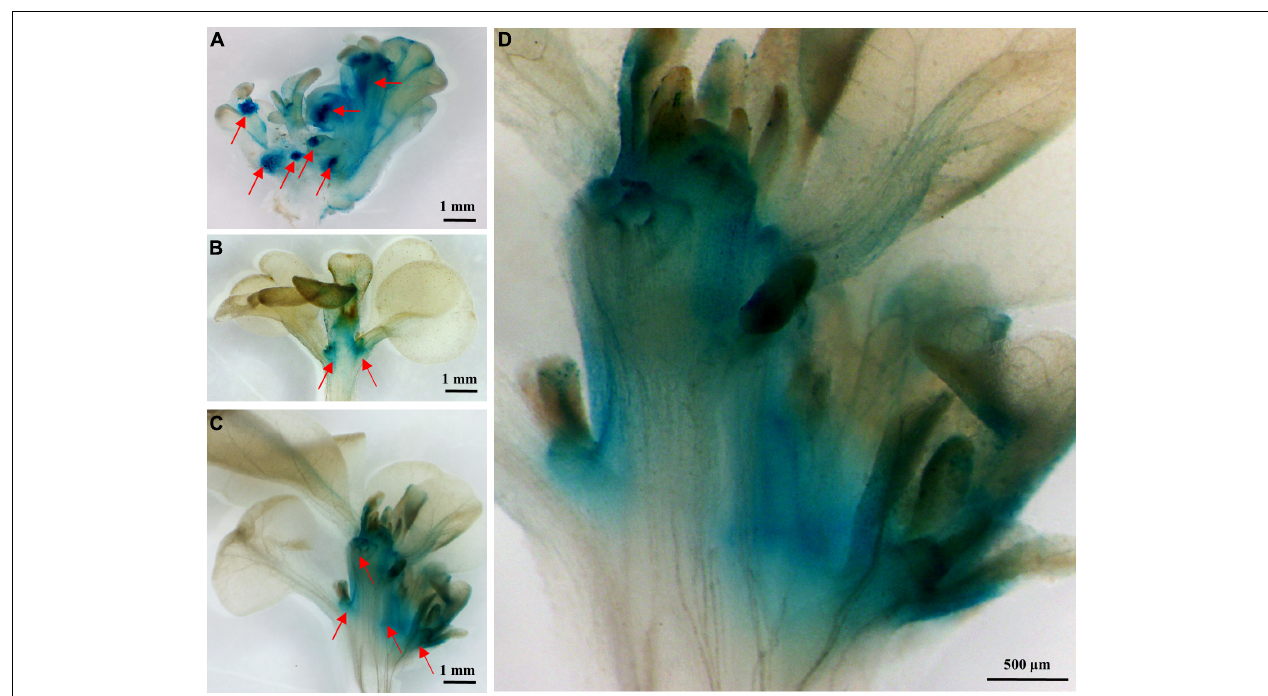
FIGURE 2 | Histochemical analysis of β -glucuronidase (GUS) activity of PsnCYCD1;1pro-GUS transgenic tobacco. (A) Adventitious buds; (B) stem tip; (C) axillary bud development of stem tip; and (D) partial enlargement of (C) .